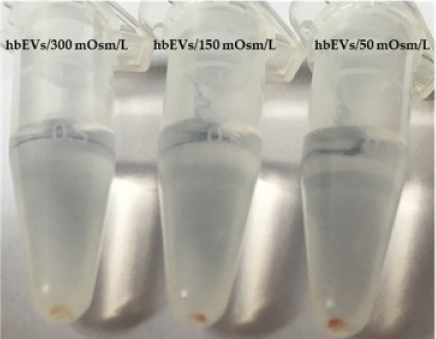
Figure A7. Samples containing hbEVs (red dots at the bottom of the tubes) in PBS–citrate with different osmolarities (from left to right: 300, 150, and 50 mOsm/L), centrifuged after 45 days of storage at 4 ◦